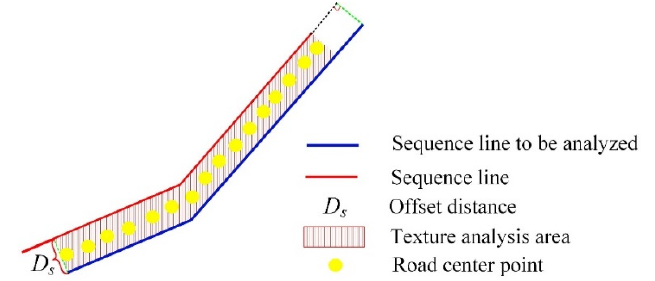
Figure 7. Schematic diagram of road center point extraction.